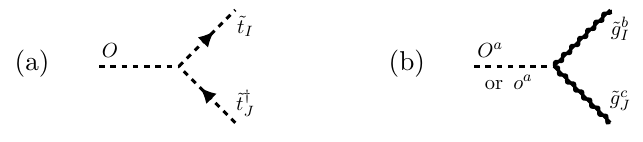
Figure 1. Diagrams for (a) scalar sgluon decays to stop squarks ˜ t I ˜ t † scalar or pseudoscalar decays to gluinos ˜ g I ˜ g J